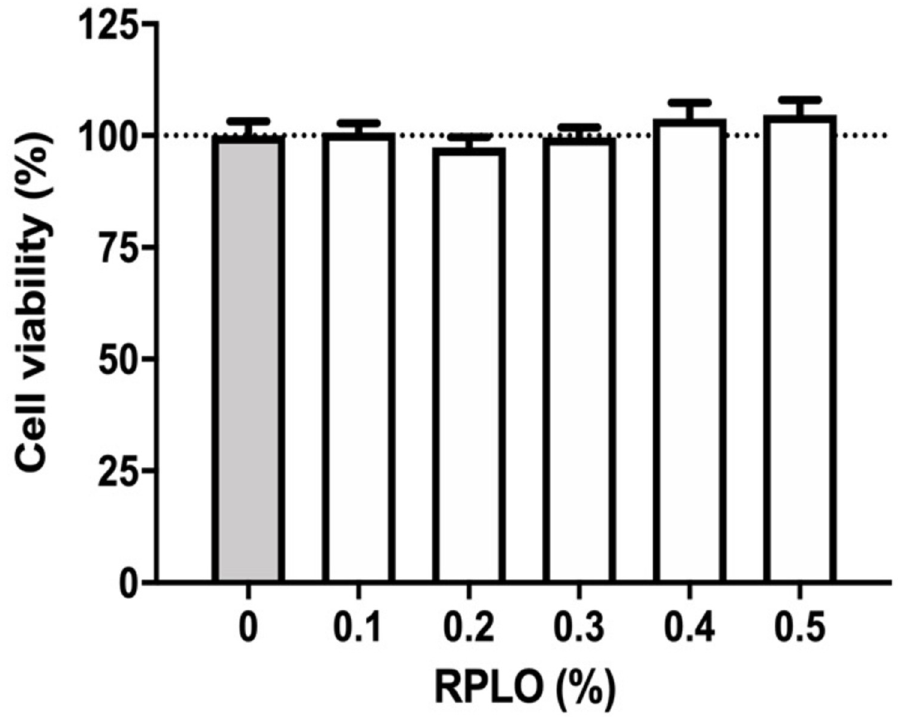
Fig 3. Viability of MRC-5 cells incubated with different concentrations of RPLO for 24 h. The graph shows the means ± SEM of three independent experiments performed in triplicate (n = 9). The observed changes were not statistically significant